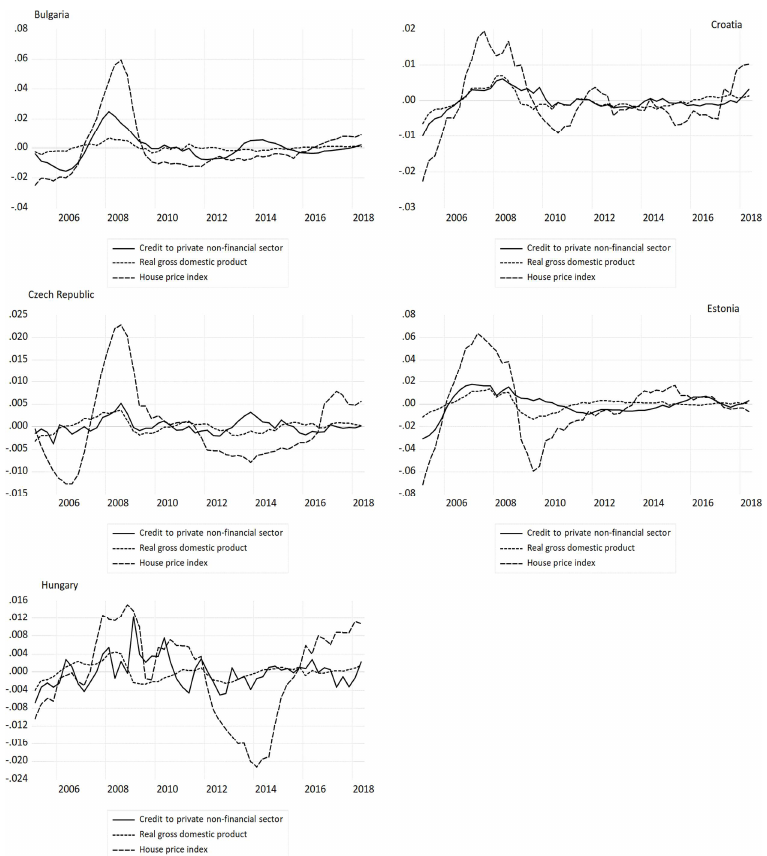
Figure 1. Extracted Cyclical Components of Credit to Private Non-Financial Sector, Real GDP and House Price Index (Bulgaria, Croatia, Czech